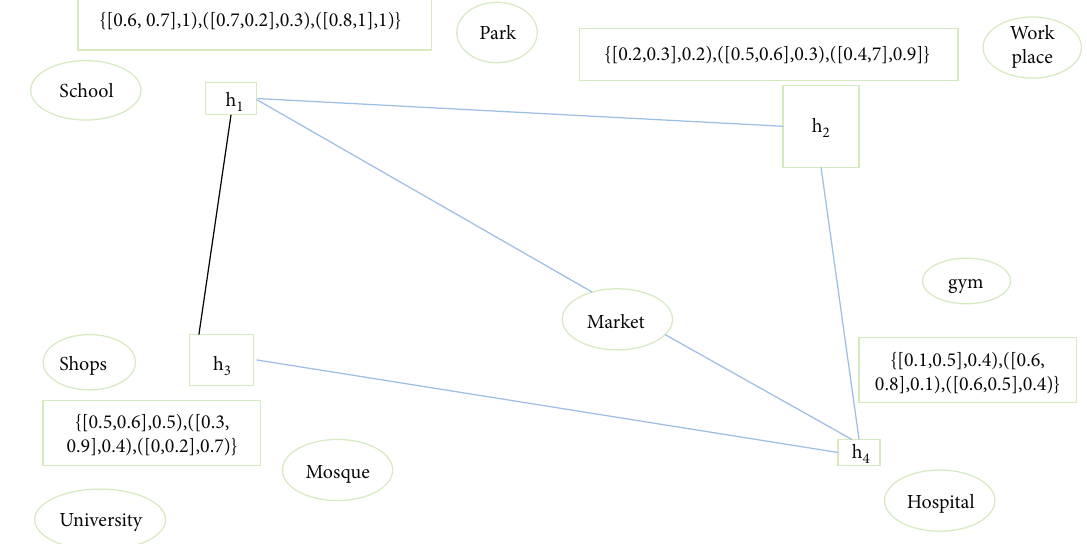
Figure 13: Represents position of four houses with di ff erent